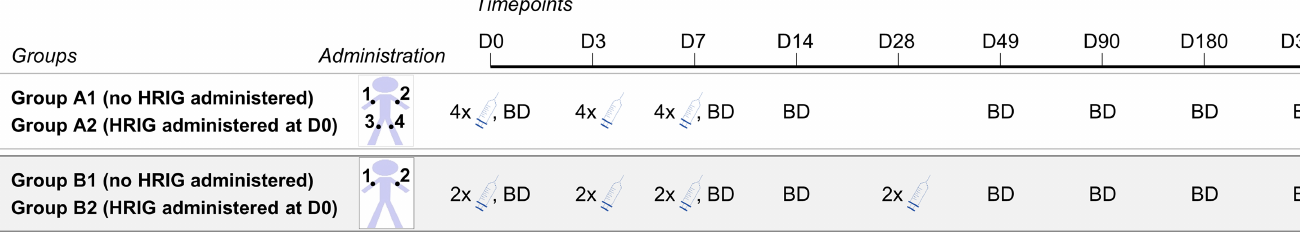
Fig 2. Study design. Group A1, participants receiving PCECV according to the 4-site/1-week ID regimen; Group A2, participants receiving PCECV according to the 4-site/1-week ID regimen and HRIG at first visit; Group B1, participants receiving PCECV according to the 2-site/TRC ID regimen; Group B2, participants receiving PCECV according to the 2-site/TRC ID regimen and HRIG at first visit; PCECV, purified chick embryo cell culture vaccine; ID, intradermal; HRIG, human rabies immunoglobulin; TRC, Thai Red Cross; D, day; BD, blood draw. Administration schemes represent injection sites. The syringe symbolizes 1 injection of 0.1 mL of PCECV